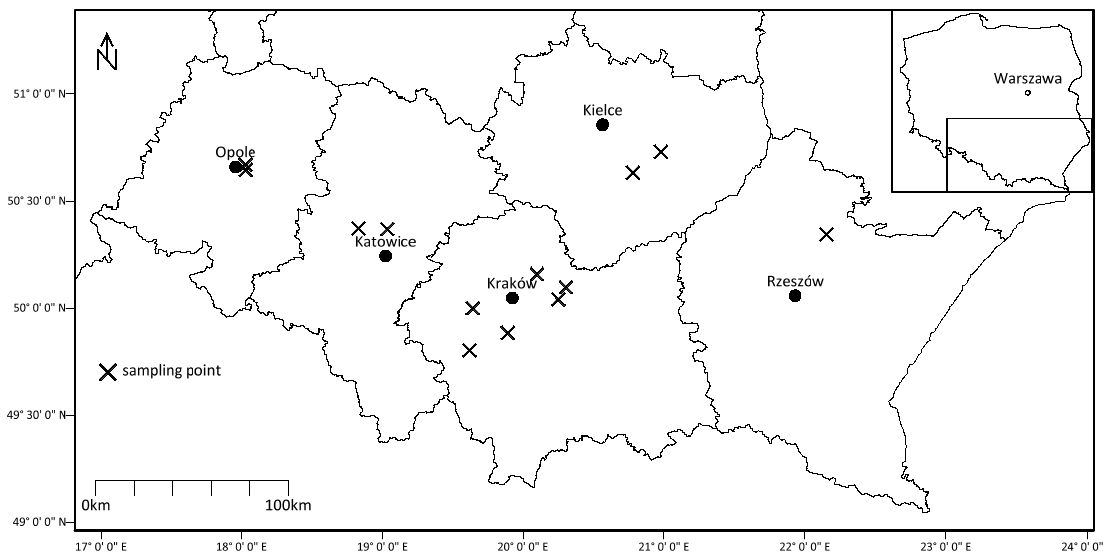
Figure 1. Agricultural soil-sampling site locations in the Regions of southern Poland (modified from [17]).